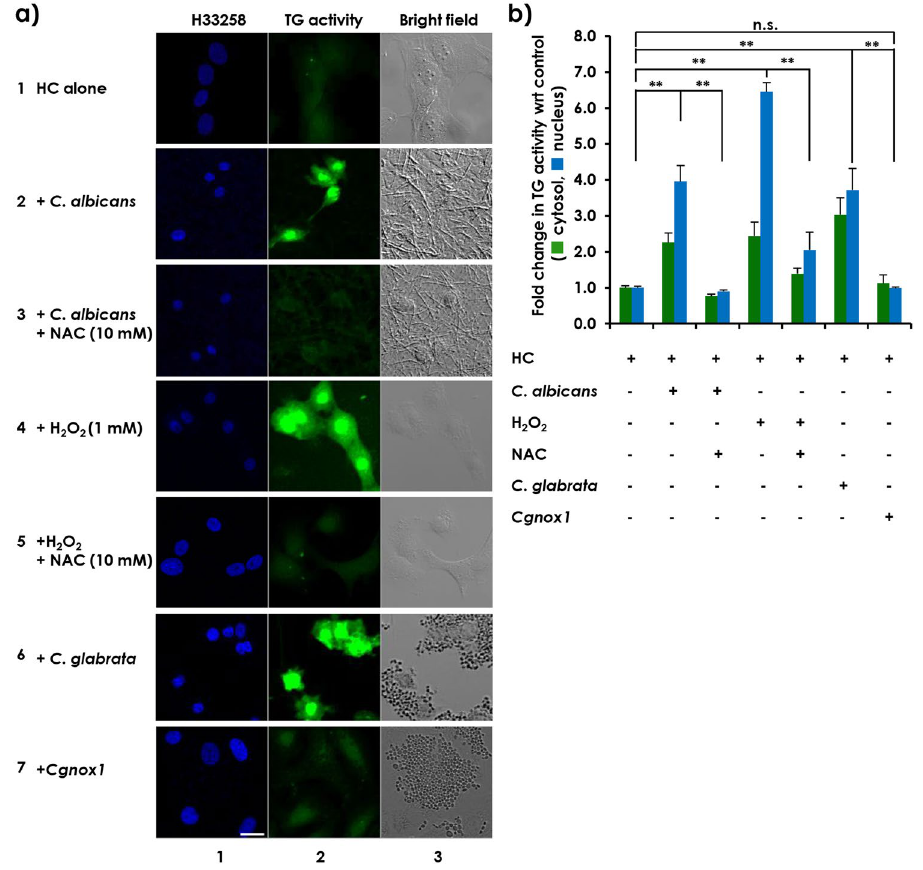
Figure 3. ROS produced by C. albicans induced cellular TG activity in HC cells. HC cells were seeded at 2 × 10 5 cells per well in a 35-mm glass-based dish or on round cover slips plated in 6-well plates and incubated overnight as previously described. ( a ) After adding 5-BAPA, the HC cells were incubated alone (row 1) or were co-incubated for 24 hours with 5 × 10 6 C. albicans cells in the absence (row 2) or presence (row 3) of 10 mM NAC, with 1 mM H 2 O 2 in the absence (row 4) or presence (row 5) of 10 mM NAC, or with 5 × 10 6 C. glabrata cells (row 6) or Cgnox1 -mutant cells (row 7). The cells were fixed and stained with streptavidin-TRITC and H33258 dye. Both the blue fluorescence signals from H33258-stained nuclei (column 1) and the green fluorescence signals representing TG activity (column 2) were detected using a confocal microscope. Images taken under the bright field (column 3) are also shown. Scale bars = 20 µ m. Representative images from at least 3 fields from 3 independent experiments are shown. ( b ) Fluorescence intensities from TRITC in both the cytoplasm and nucleus were quantitated using ZEN 2011 software, and the relative TG activity levels in both locations are represented in bar graphs, with the level from HC cells incubated alone used as the control (mean ± SD, n =